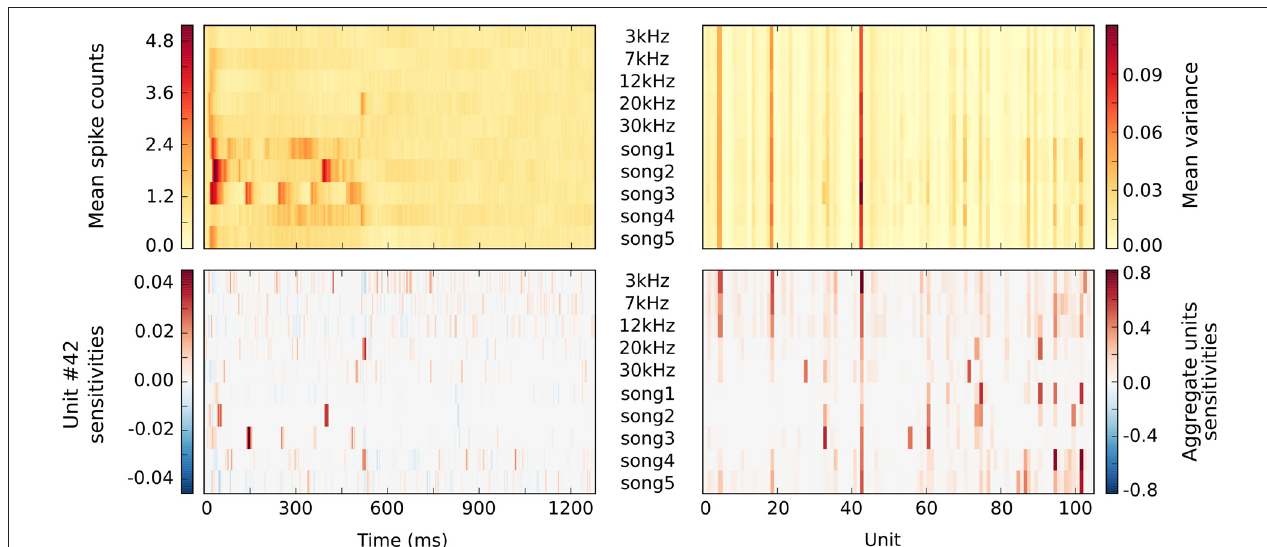
FIGURE 5 | Statistics of multiple single unit extracellular simultaneous recordings and corresponding classifi er sensitivities. All plots sweep through different stimuli along vertical axis, with stimuli labels presented in the middle of the plots. The upper part shows basic descriptive statistics of spike counts for each stimulus per each time bin (on the left) and per each unit (on the right). Such statistics seem to lack stimulus specifi city for any given category at a given time point or unit. The lower part on the left shows the temporal sensitivity profi le of a representative unit for each stimulus. It shows that stimulus specifi c